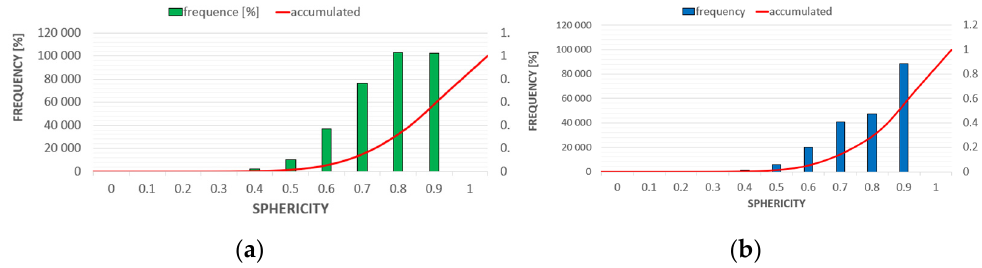
Figure 11. Frequency of pores with different sphericity ranges: ( a ) for C-C series concrete, ( b ) for C-RA series